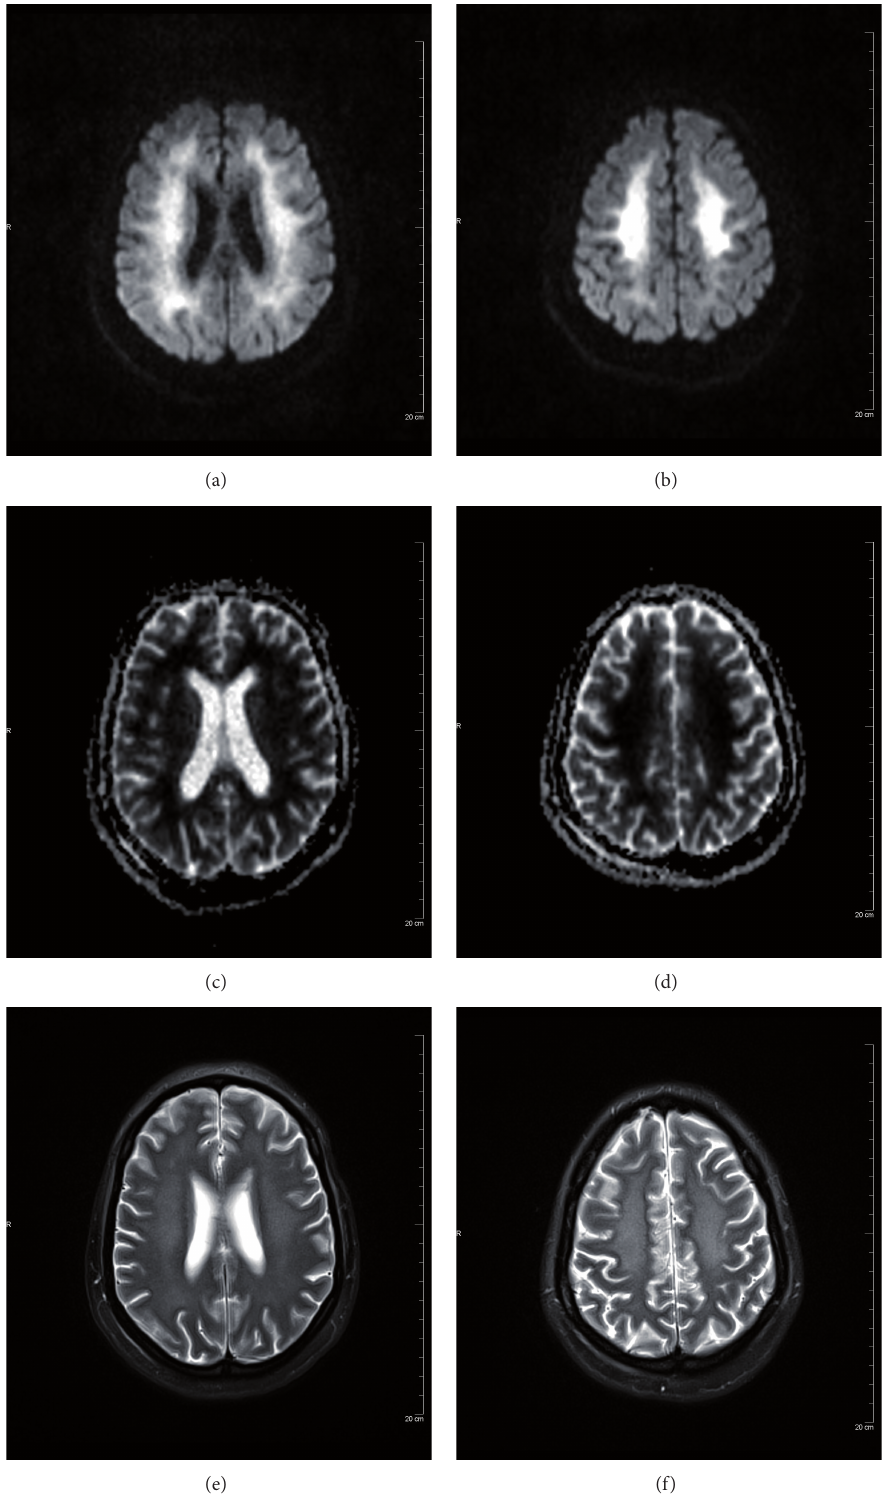
Figure 4: (a) DWI, Diffusion weighted images bilateral and symmetric diffusion restriction in the deep white matter. (b) DWI, Diffusion weighted images show bilateral and symmetric diffusion restriction in the corona radiata. (c) ADC map shows loss of the increased signal seen in the DWI images in the bilateral deep white matter. (d) ADC map shows loss of the increased signal seen in the DWI images in the bilateral corona radiata. (e) Axial T2 TSE FS (Blade) acquired in 4mm thickness, shows hyperintense T2 signal abnormality in the deep white matter. (f) Axial T2 TSE FS (Blade) acquired in 4 mm thickness, shows hyperintense T2 signal abnormality in the corona